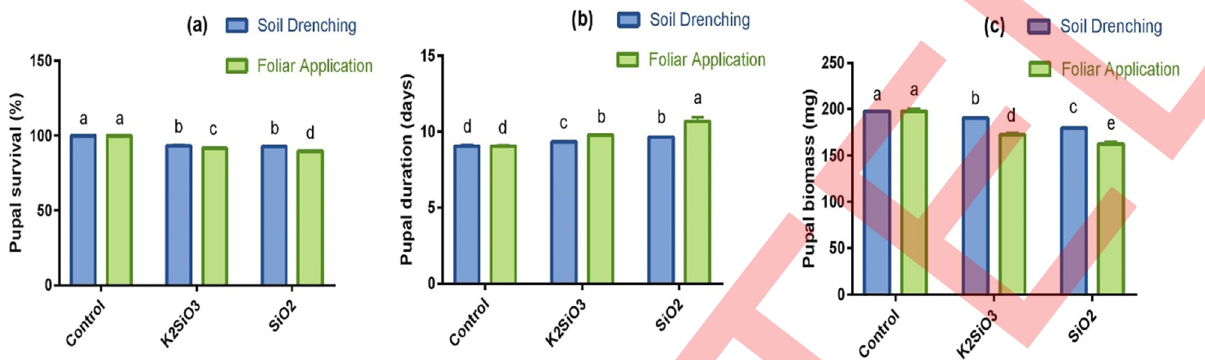
Fig 2. Effect of silicon sources and silicon application methods on (a) pupal survival percentage, (b) pupa duration (days), and (c) pupa biomass (mg) of fall armyworm. Bars with different lower-case letters are significantly different; LSD test at p � 0.05. Vertical bars indicate SD.